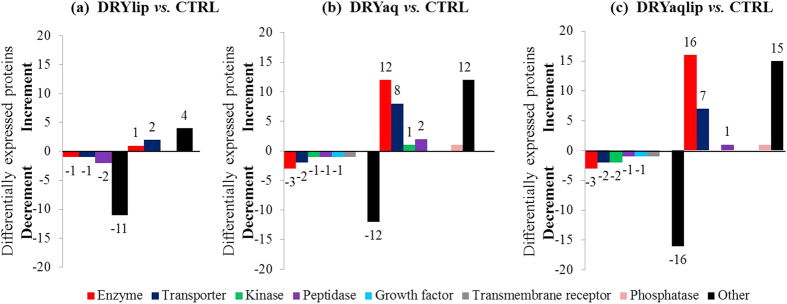
The bar charts shows the over-represented molecular type terms associated with the differentially expressed proteins analysed employing the Ingenuity Pathways Analysis software in (a) DRYlip vs. CTRL, (b) DRYaq vs. CTRL and (c) DRYaqlip vs. CTRL.